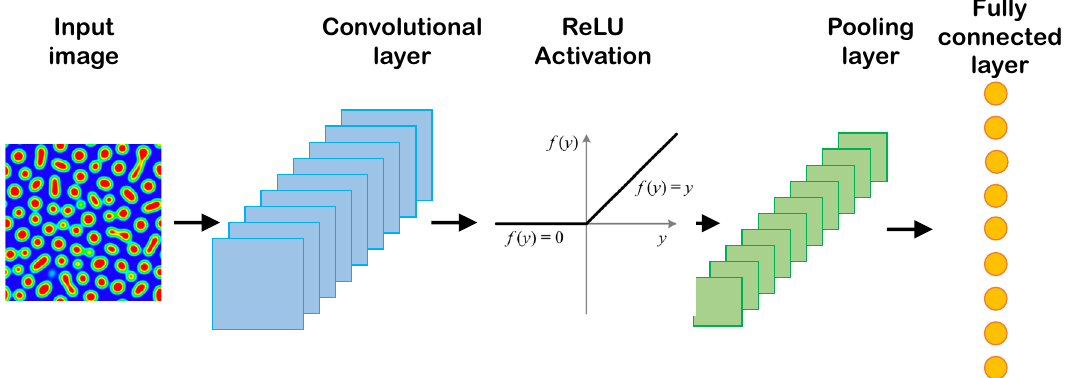
Figure 1. Schematic of a typical convolutional neural